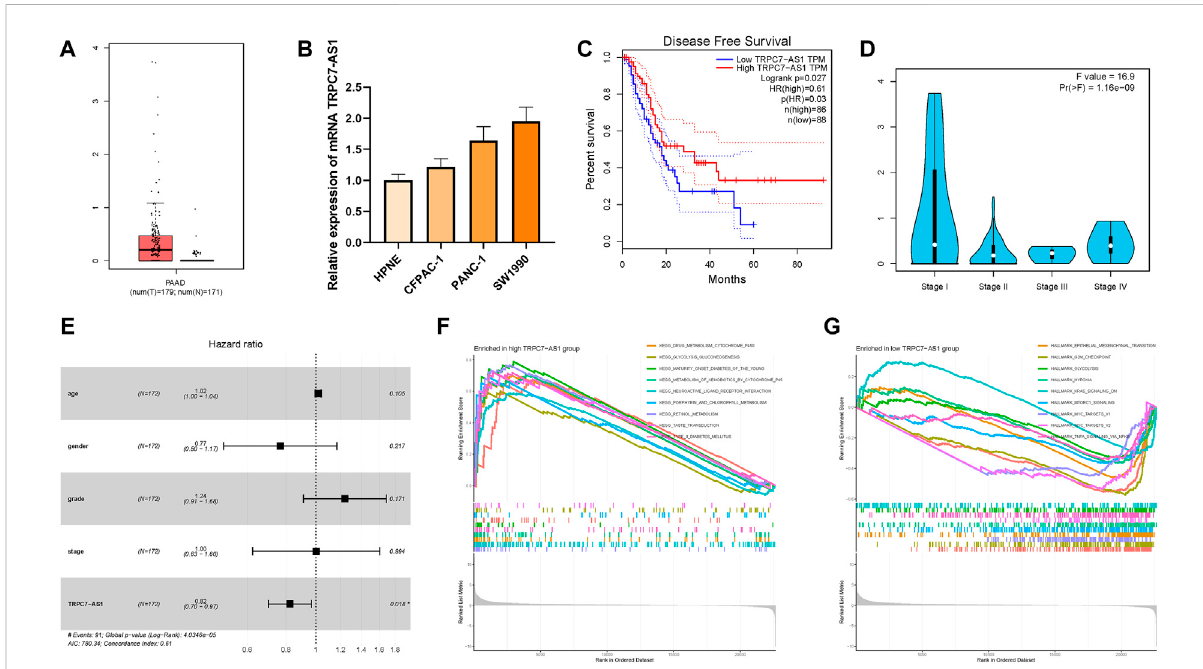
FIGURE 11 Clinical signi fi cance of TRPC7-AS1 in PDAC. TRPC7-AS1 are upregulated in PDAC samples based on TCGA and GTEx datasets (A) and cell lines (B) , and higher TRPC7-AS1 expression level was signi fi cantly correlated with improved prognosis (C) . (D) Expression of TRPC7-AS1 had a signi fi cant difference between major pathological stages. (E) Multivariate Cox regression results of overall survival. The length of the horizontal line represents the 95% con fi dence interval for each group. The vertical dotted line represents the hazard ratio (HR) of all patients. (F) Enriched gene sets in KEGG collection by the high TRPC7-AS1 expression sample. (G) Enriched gene sets in Hallmarker collection by the low TRPC7-AS1 expression